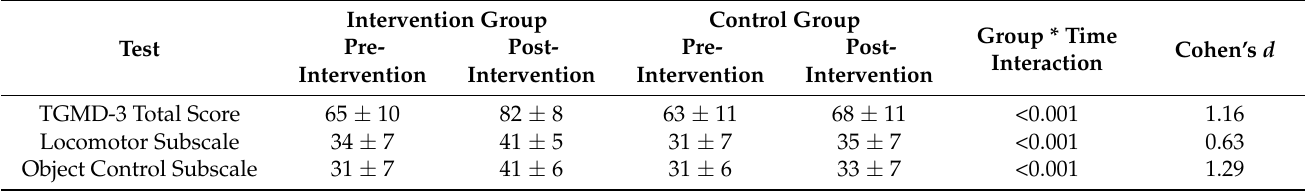
Table 3. Gross motor skill data, pre- and post- intervention, in the intervention and control groups. Data are mean ±